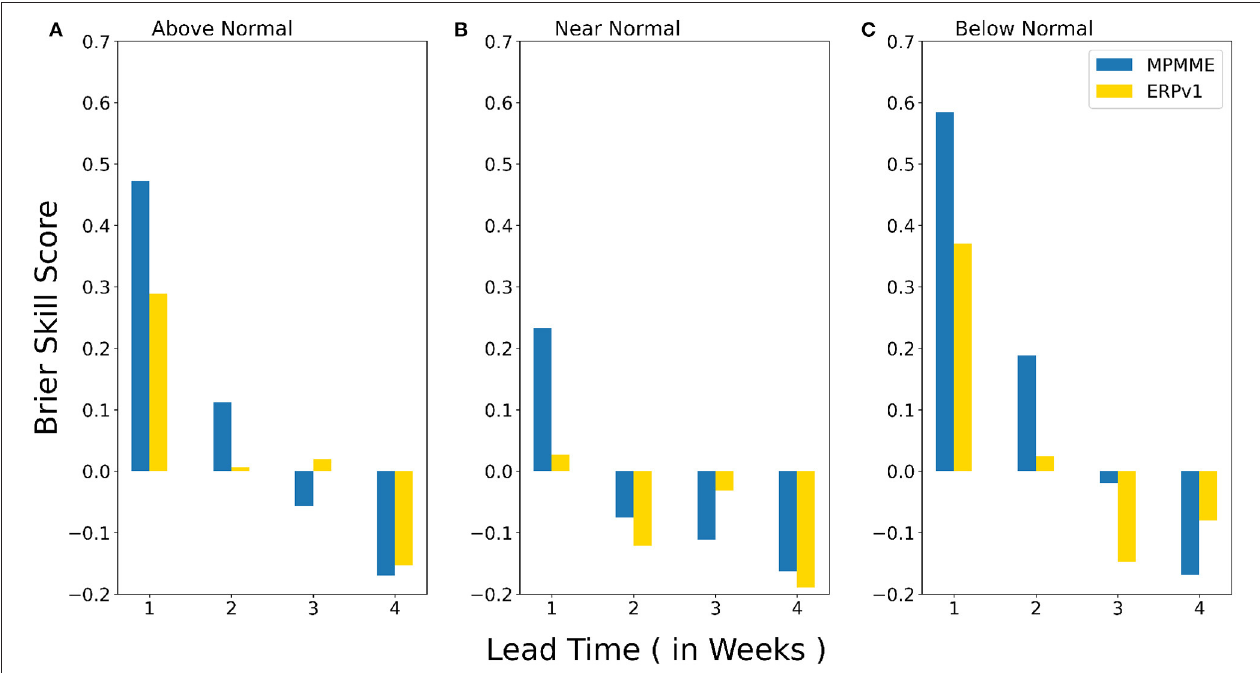
FIGURE 8 | Brier skill score from extended range prediction system (ERPv1) and multi-physics multi-model ensemble (MPMME) for (A) above normal, (B) near normal, and (C) below normal categorical rainfall forecast over monsoon zone.